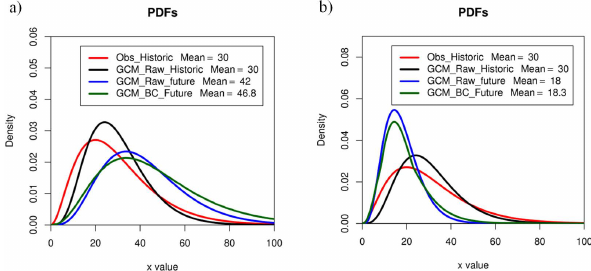
Fig. 2. Probability density functions for the same synthetic data in Fig. 1, but including the post-bias correction GCM future projec- tion.